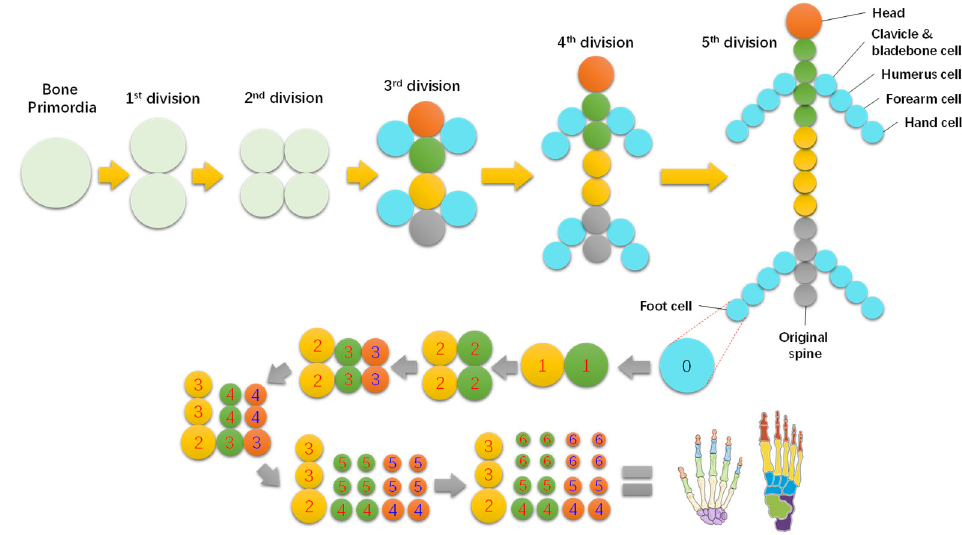
Figure 3. Brief formation route of human skeleton and hand and foot bones.